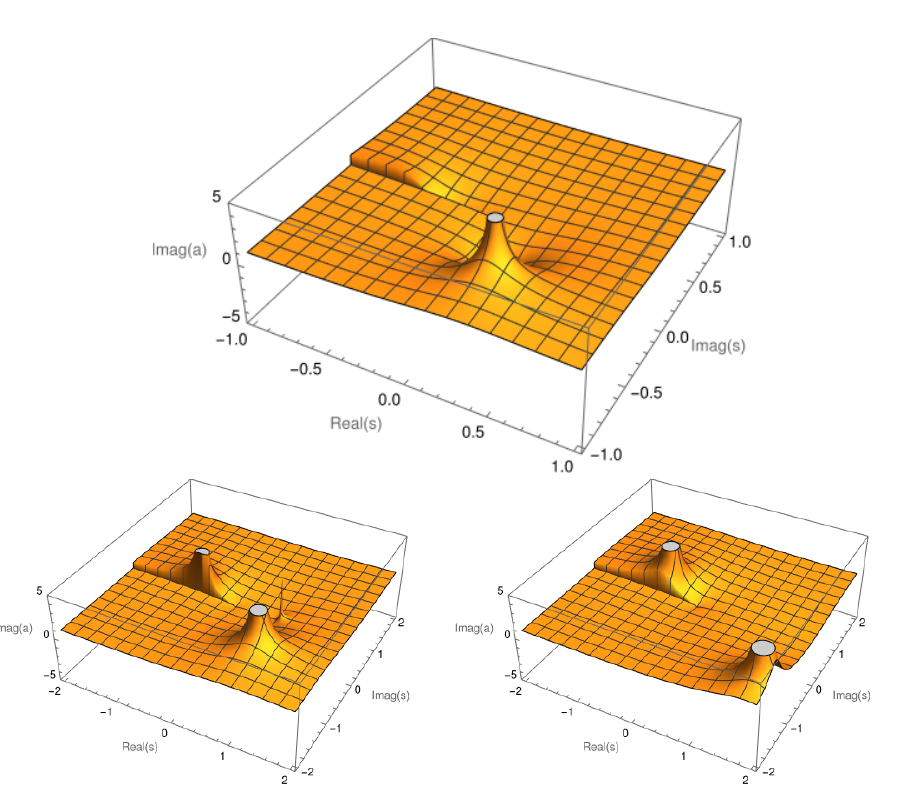
Figure 3. From top, anticlockwise: plots of Im a IAM